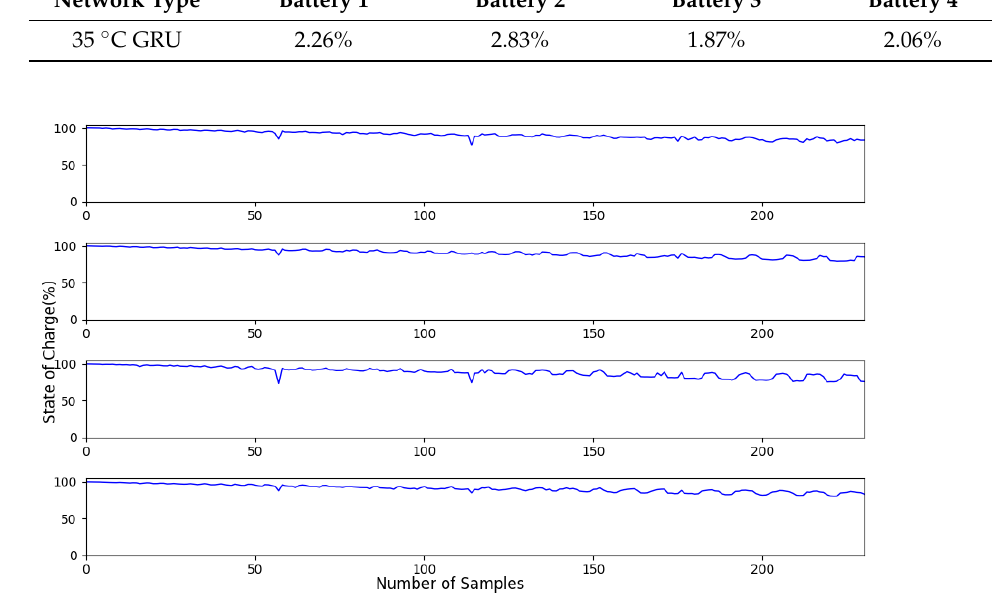
Figure 14 . Real-time SOC estimation using the GRU